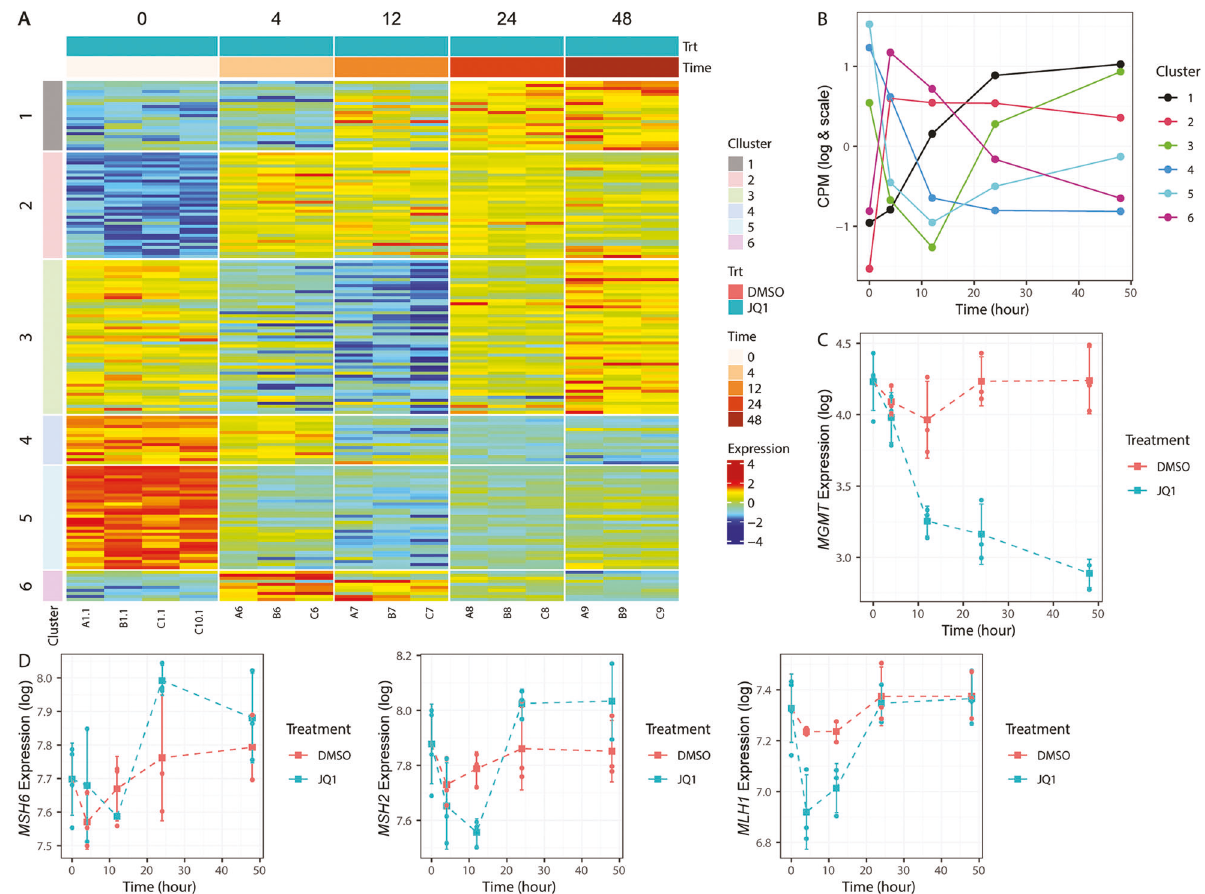
into the six clusters of response to the treatment de fi ned by the two-step procedure based on Fréchet distances. B The six averaged expression patterns of DDR genes are displayed upon clustering over the time course of treatment. C The expression pro fi le of the MGMT gene, classi fi ed into cluster 4, is represented in function of the time and strati fi ed by tretament (JQ1 in blue and DMSO in red). D Similarly, the expression pro fi les of MMR genes MSH6 , MSH2 and MLH1 upon JQ1 (red) or DMSO (blue) treatment are shown over the time course of 48 h, classi fi ed into cluster 3. The circles and squares correspond to the biological replicates and the means of the three independent biological replicates for each time point, respectively. The standard deviations (SD) are represented by the vertical